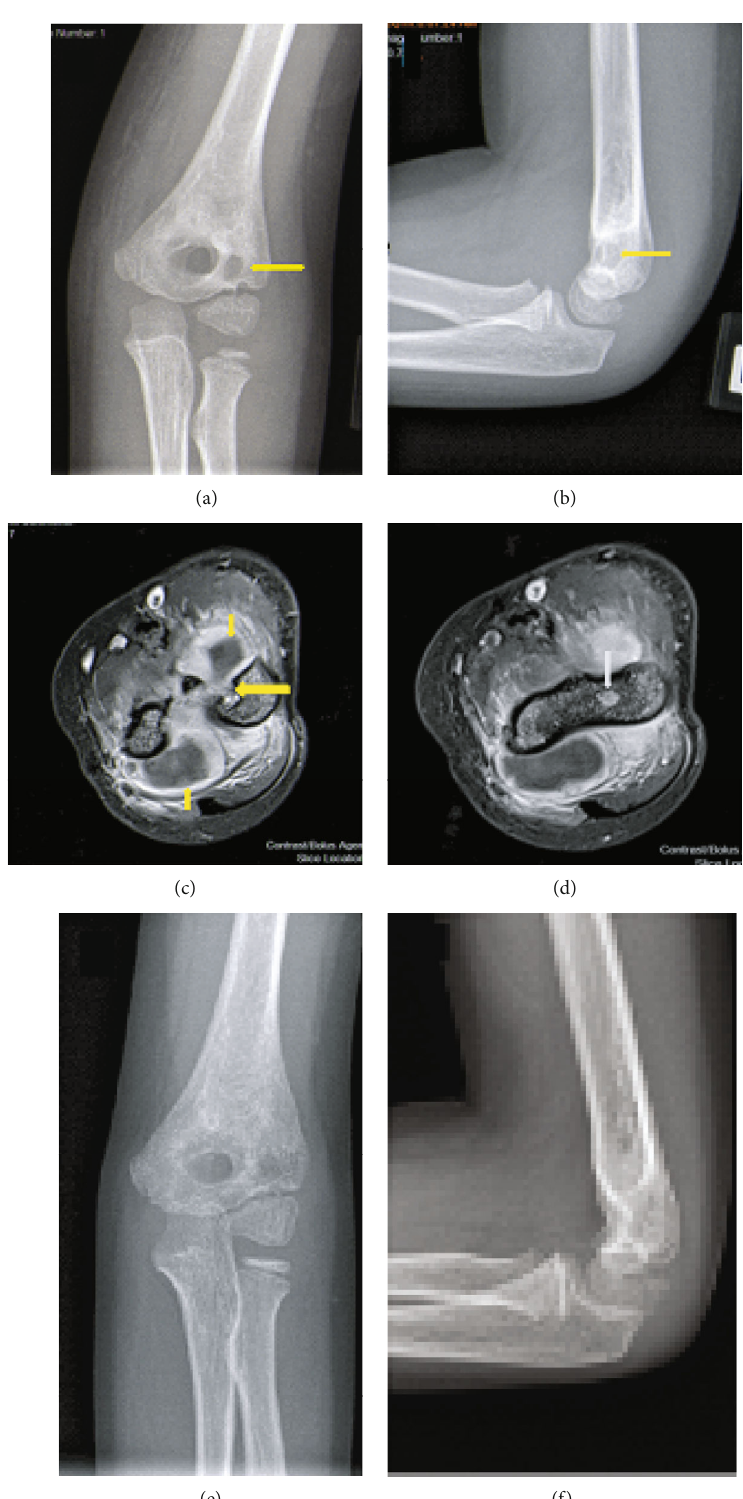
Figure 2: (a, b) AP and lateral x-rays showing a distal humeral lucency concerning for chronic osteomyelitis. (c, d) Axial T1 post contrast MRI. (c) The large arrow denotes nidus of infection. (d) The large arrow denotes anterior cortical disruption. The small arrows denote purulent fl uid collection in elbow joint. (e) and (f) are radiographs one year after irrigation and